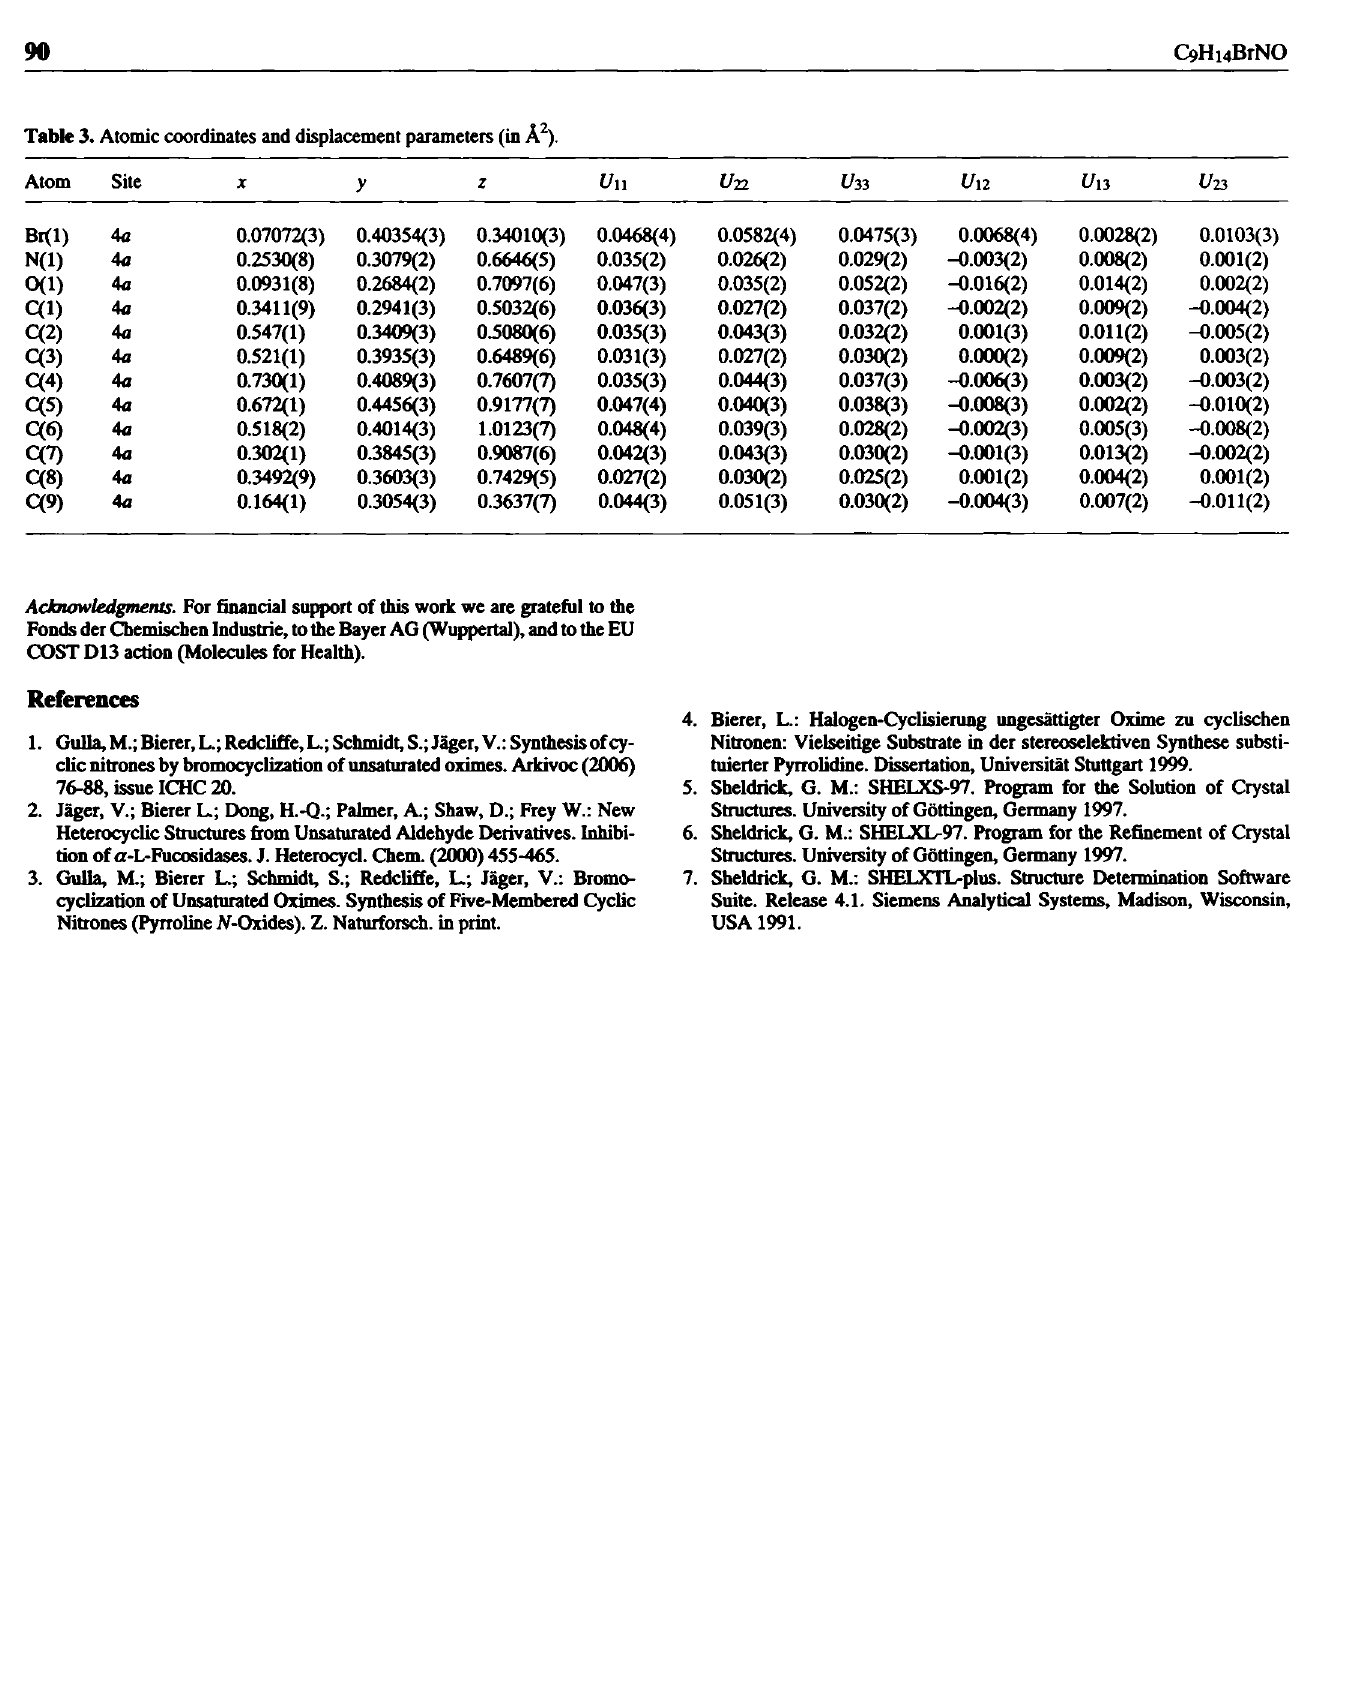
Table 3. Atomic coordinates and displacement parameters (in A 2